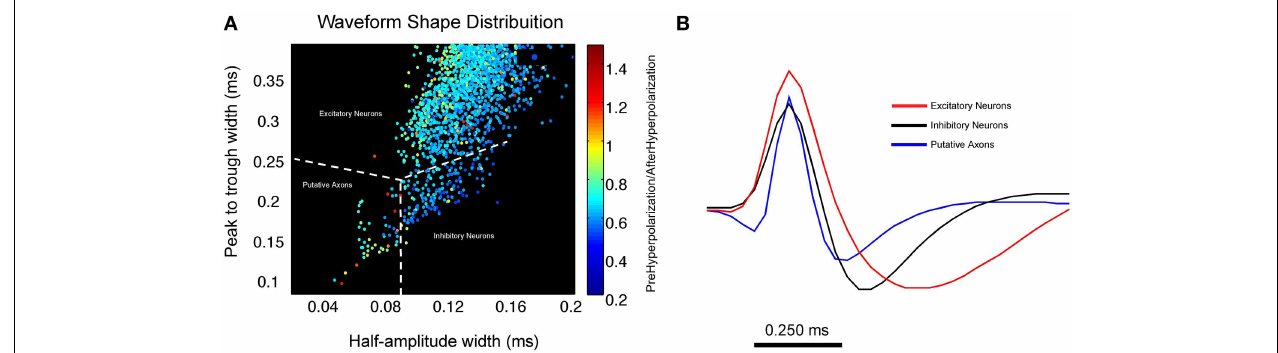
FIGURE 4 | Using waveform shape distributions to cluster excitatory, inhibitory and putative axonal activity in the medial prefrontal cortex. (A) Scatterplot of waveform distribution that plots peak-trough width against half amplitude width. Each data point represents an individual cell waveform that is color coded to reflect its pre-hyperpolarization and post-hyperpolarization ratio. The use of secondary waveform features in conjunction with spike duration allows for the reliable separation of 3 distinct clusters of excitatory and inhibitory neurons as well as putative